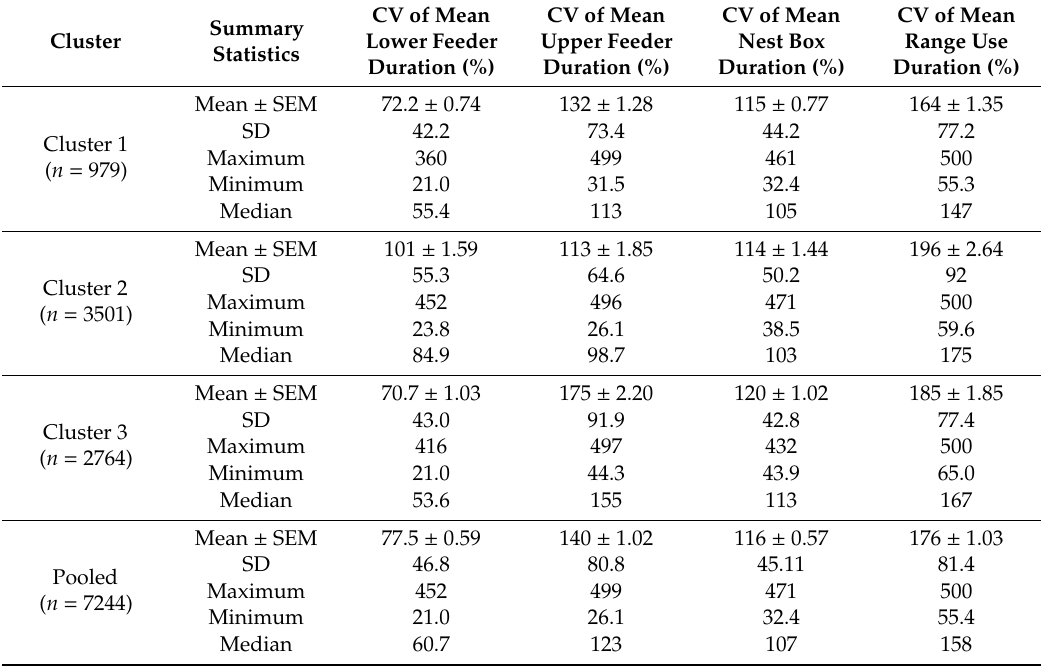
Table 3. The descriptive statistics of the CV for the daily duration of the three clusters detected in commercial free-range flocks.